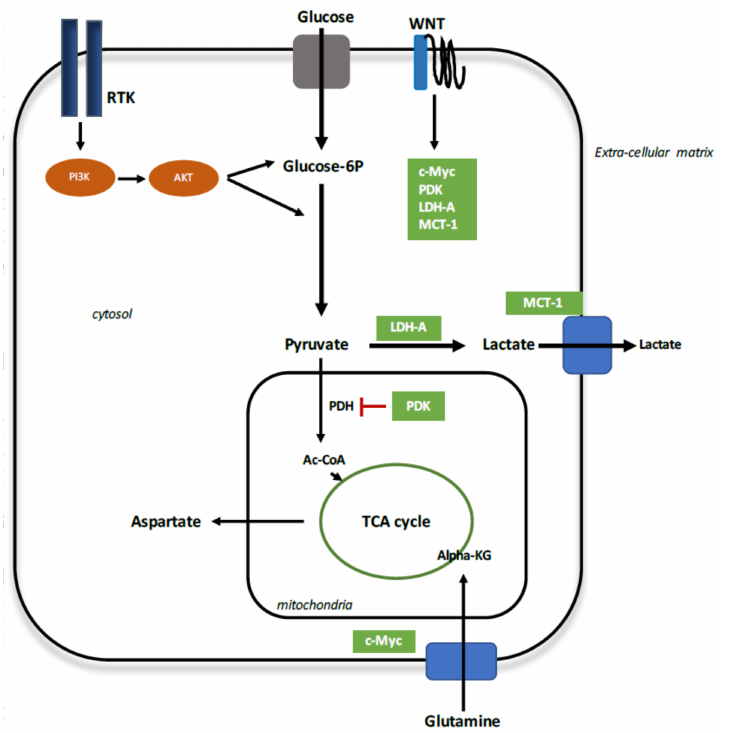
Figure 2. Aerobic glycolysis stimulation by activated canonical WNT/ β -catenin pathway. Activation of the receptor tyrosine kinase (RTK) is required to take up enough glucose to cell survival.